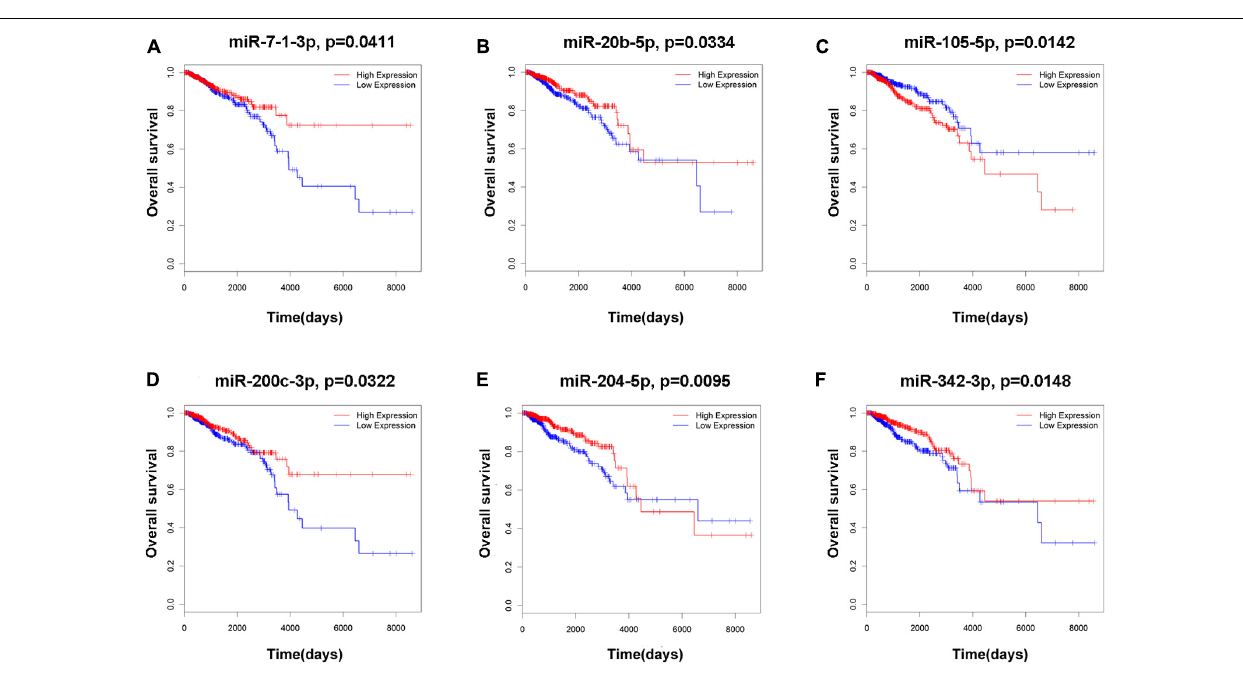
FIGURE 5 | Kaplan–Meier survival curves for six miRNAs associated with overall survival. (A) miR-7-1-3p. (B) miR-20b-5p. (C) miR-105-5p. (D) miR-200c-3p. (E) miR-204-5p. (F)